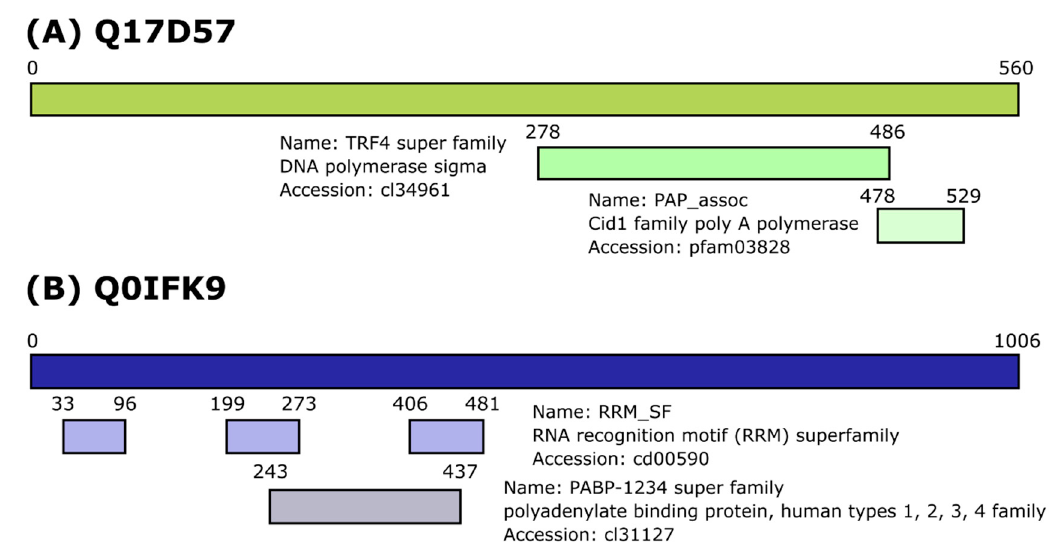
Figure 2. Description of novel Aedes aegypti Dcr2 interactors. Conserved protein domains based on National Center for Biotechnology Information (NCBI) Conserved Domain Database in Q0IFK9 ( A ) and Q17D57 ( B ).